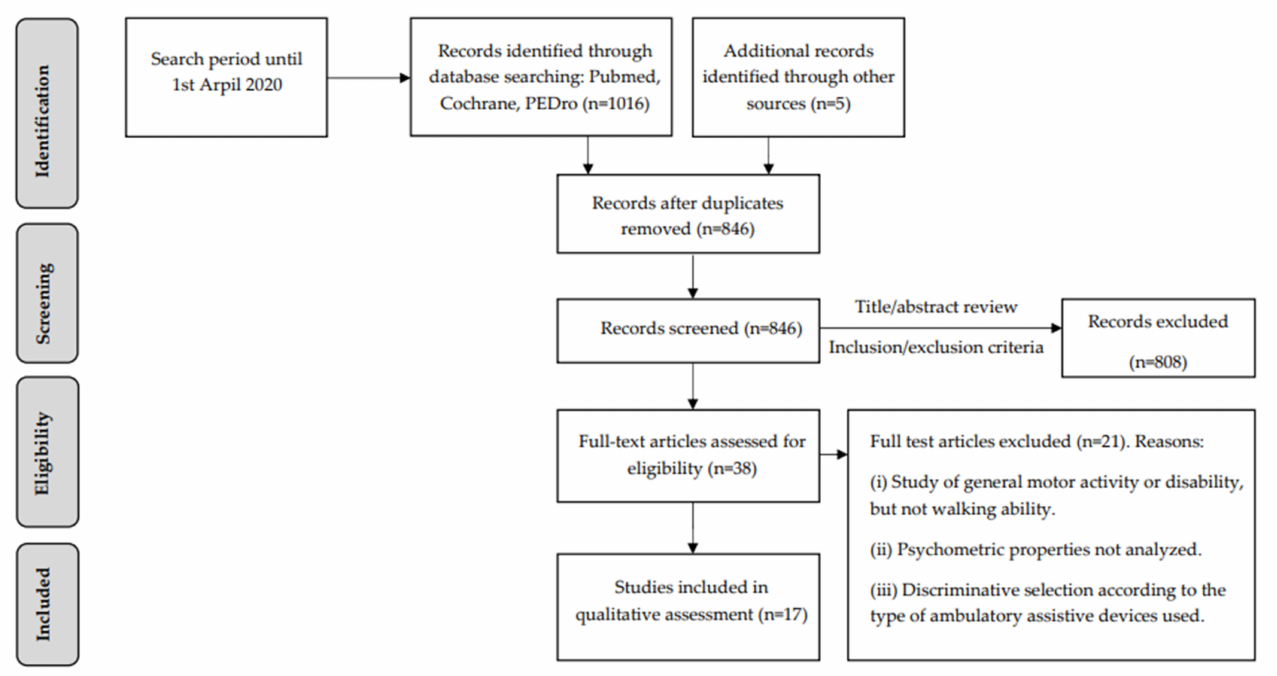
Figure 1. Flow diagram of the search strategy results.